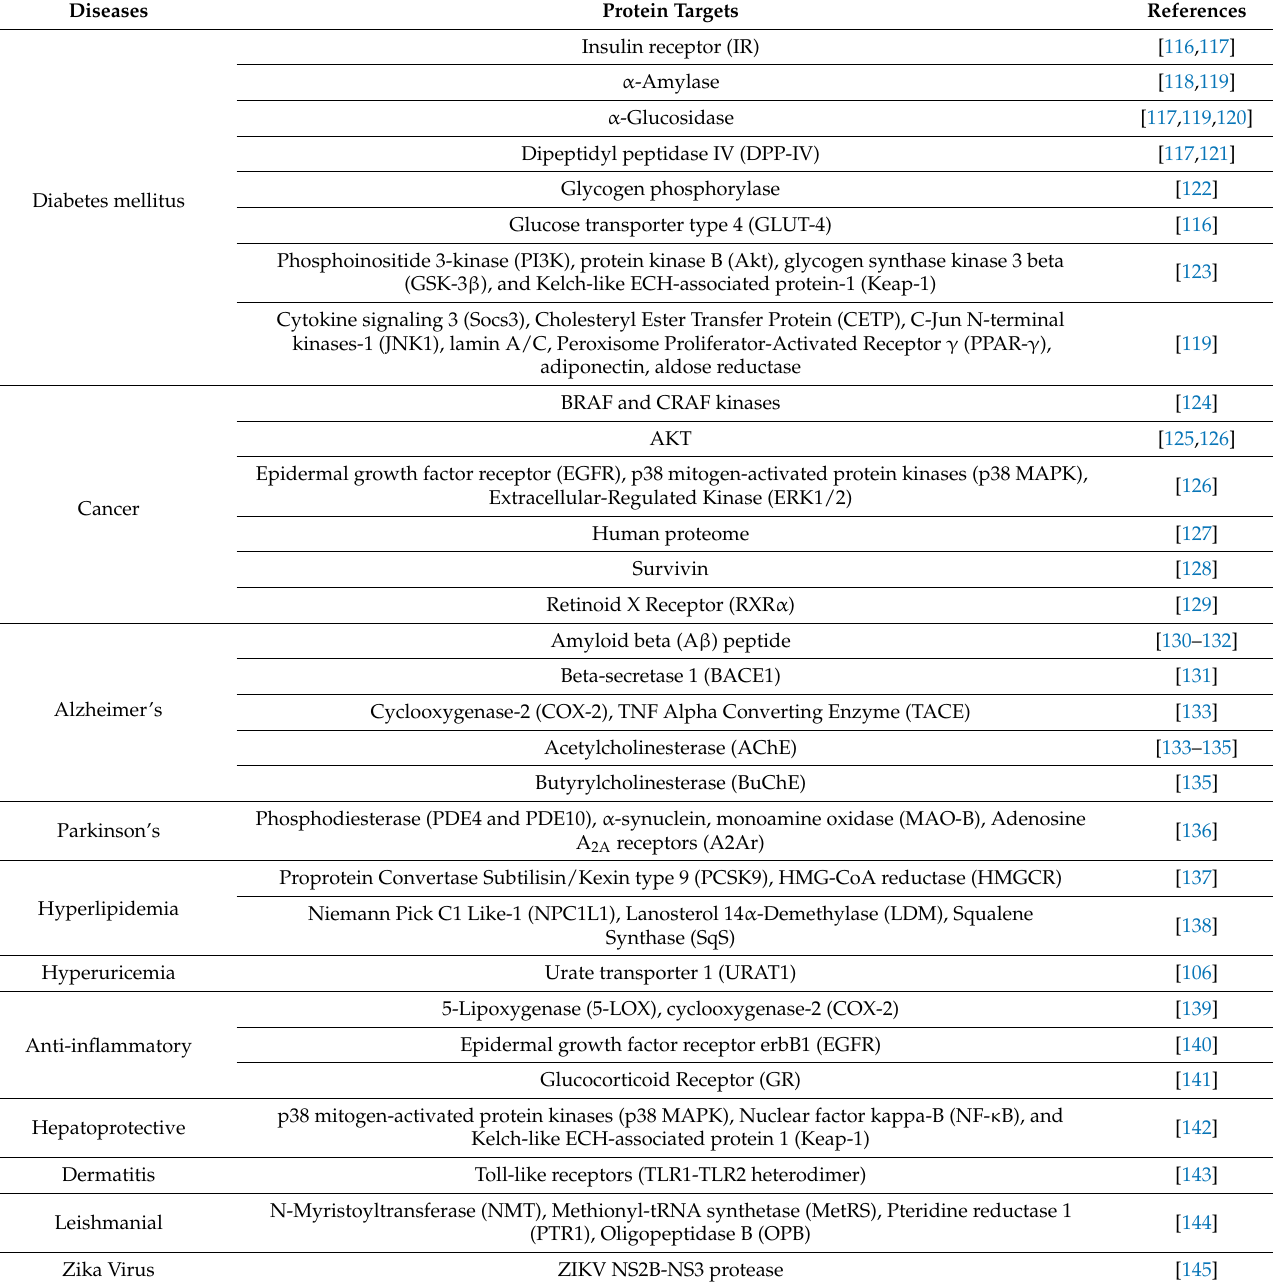
Table 2. In silico studies of berberine in several diseases and the protein